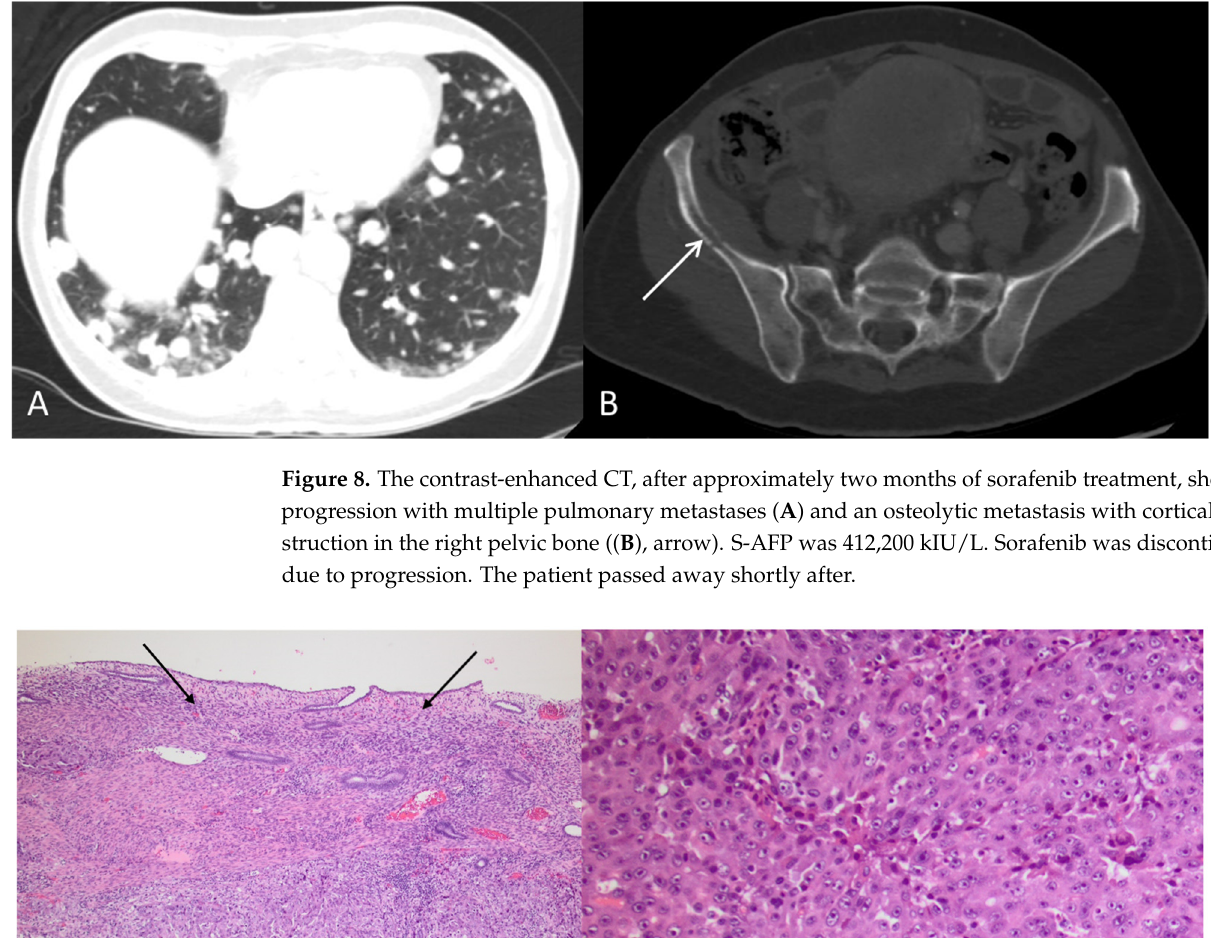
this time, the patient had also received radiation therapy (3Gyx10) of the uterus as palliative treat-